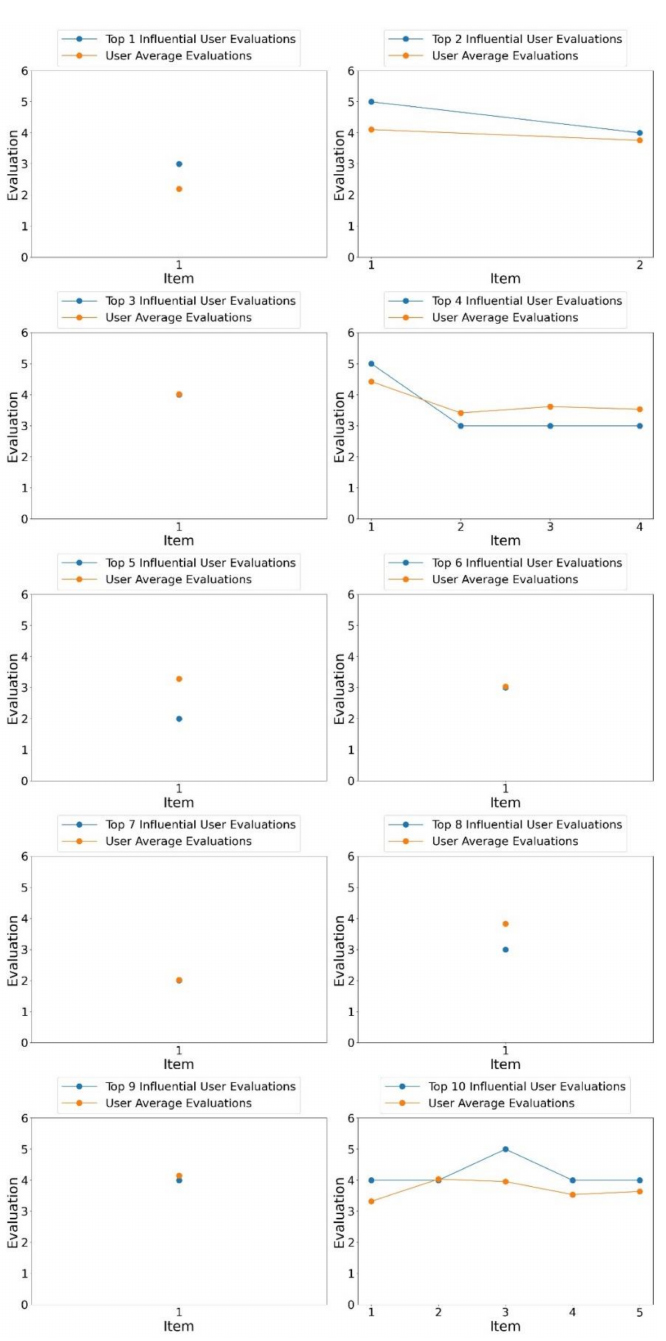
Figure 9. Comparison of the evaluations by the top 10 influential users with the average evaluations by all